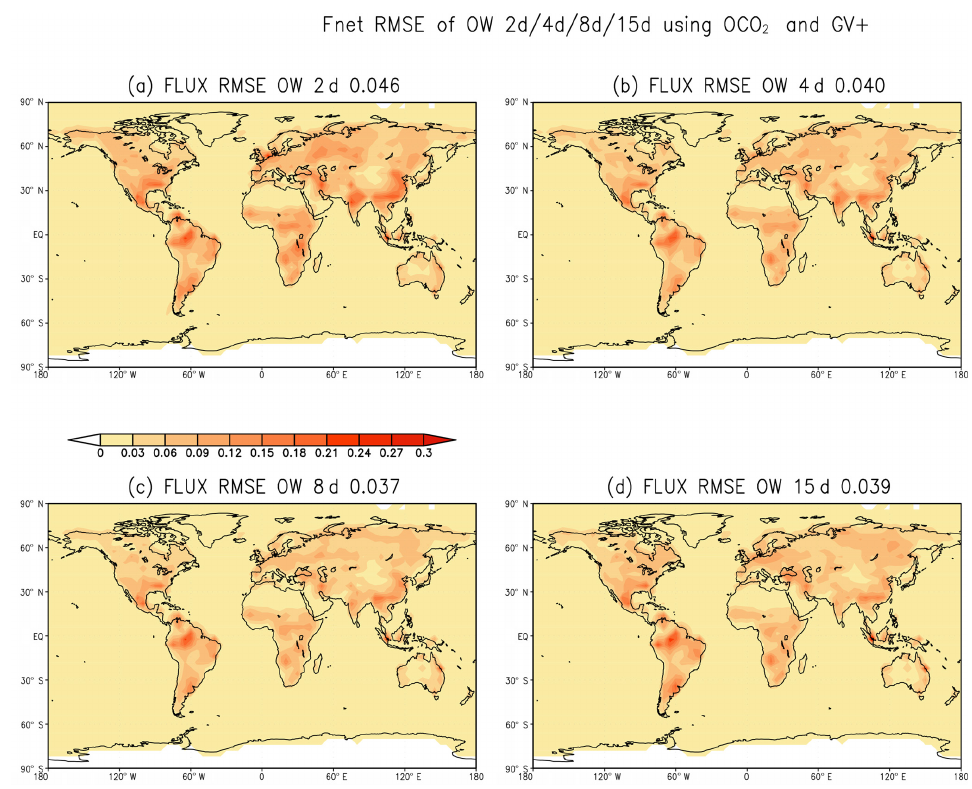
Figure 10. Same as Fig. 5, except for assimilating both OCO-2 and GV + pseudo-observations. Panels (a) , (b) , (c) , and (d) show the results with OWs of 2, 4, 8, and 15d